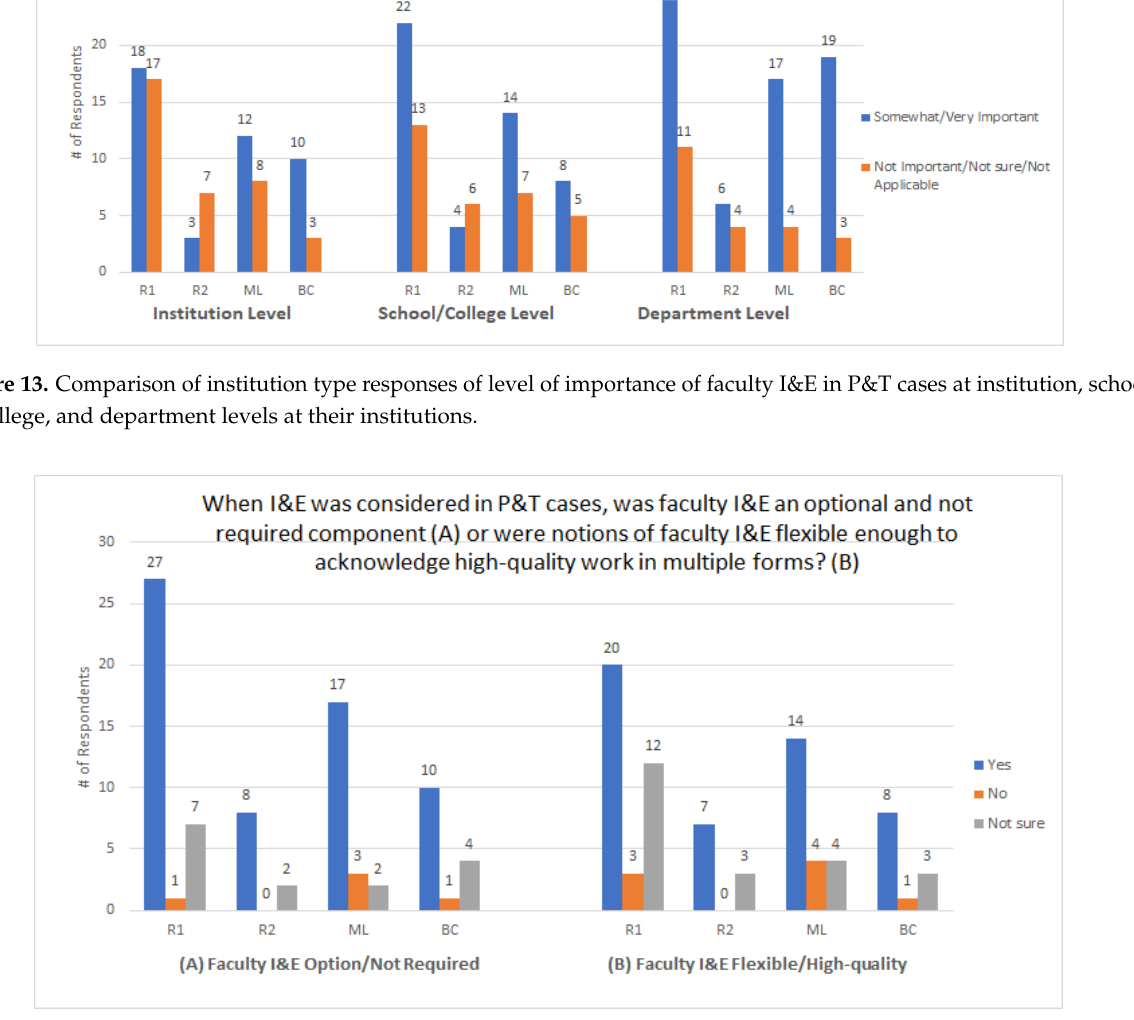
Figure 14. Comparison of institution type responses of the optional and flexible nature of faculty I&E when it was considered in P&T cases at their institutions.